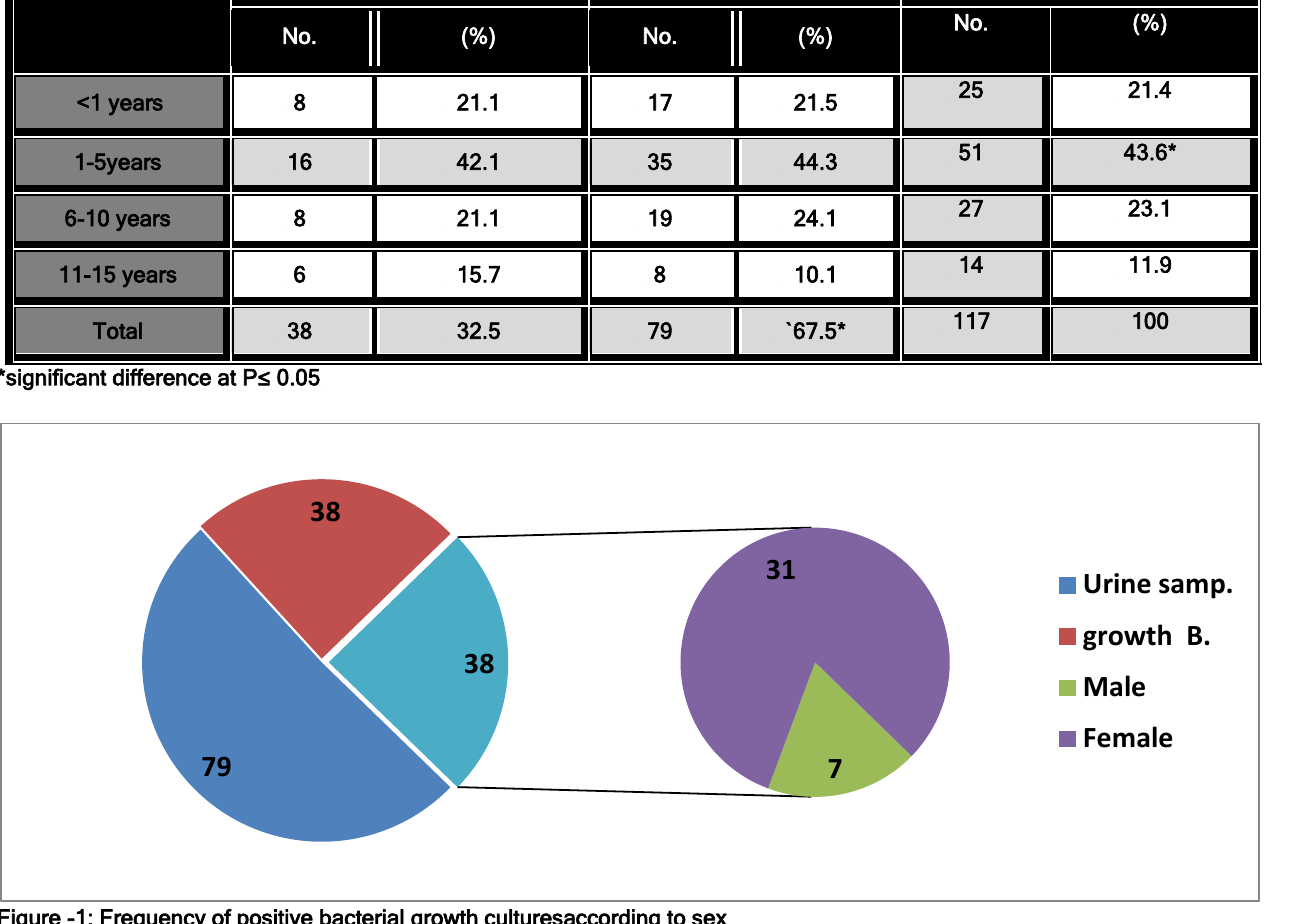
Figure -1: Frequency of positive bacterial growth culturesaccording to sex